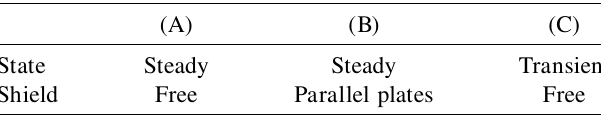
TABLE I. Conditions of the analytic solutions. (A) (B) (C)